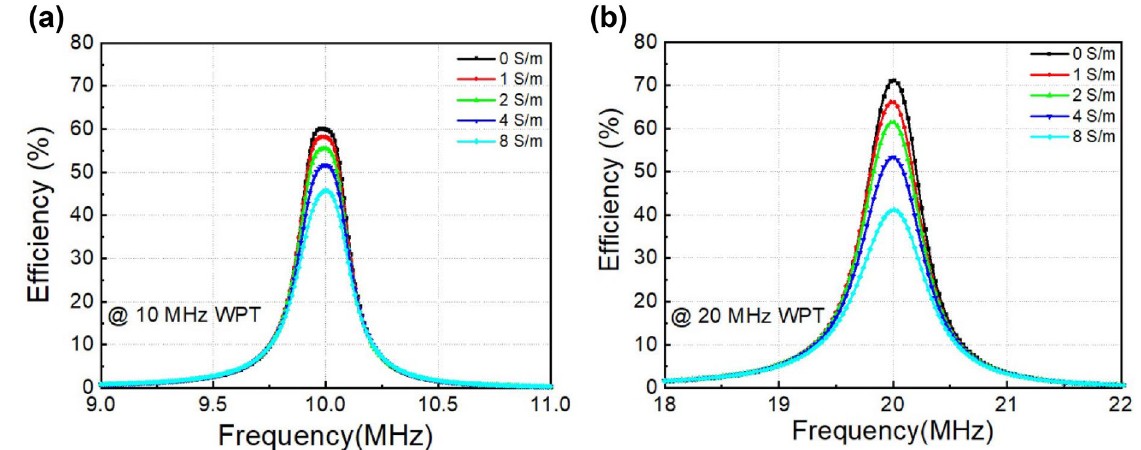
Figure 7. Measured transfer efficiency as a function of frequency of MR-WPT system with various conductivity, (a) operating frequency at 10.0 MHz, (b) operating frequency at 20.0 MHz.